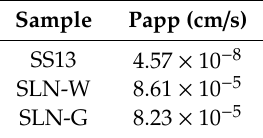
Figure 12. Ex vivo distribution of SS13 during the permeation test (30, 60 and 120 min) through the intestinal mucosa ( n = 3). * p < 0.05, SLN-G on mucosa 120 min vs. SLN-G on mucosa 60 min; + p < 0.05, SLN-G inside mucosa 120 min vs. SLN-G inside mucosa 30 and 60 min; ° p < 0.05, SS13 on mucosa 120 min vs. SLN-W on mucosa 120 and SLN-G on mucosa 120 min; & p < 0.05, SLN-G inside mucosa 120 min vs. SLN-W inside mucosa 120 min and SS13 inside mucosa 120 min; # p < 0.05, SS13 permeated 120 min vs. SLN-W permeated 120 min and SLN-G permeated 120 min; § p < 0.05, SLN-W permeated 120 min vs. SLN-G permeated 120 min. Table 6. Apparent permeability coefficient of SS13, SLN-W and SLN-G.